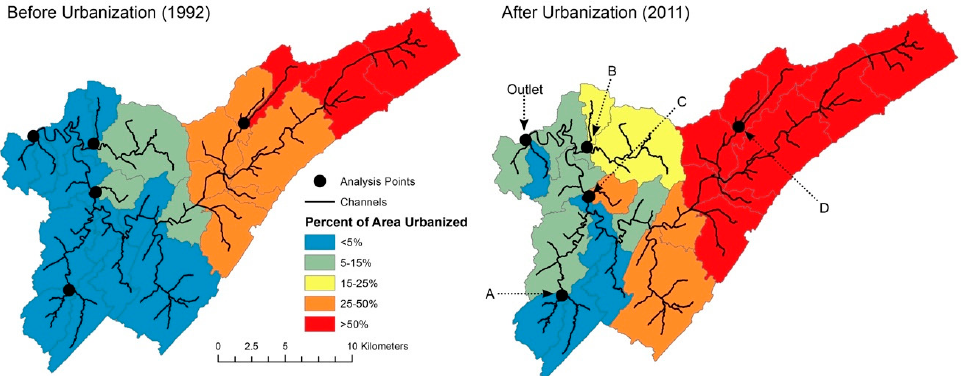
Figure 3. Scatterplots and trendlines for streamflow signatures for the urbanized (open symbols, dashed lines) and comparison (close symbols, solid lines) in Alabama (red) and Georgia (blue). The watersheds with significant trends are indicated in each panel. Streamflow elasticity is not shown because no significant trends were detected.